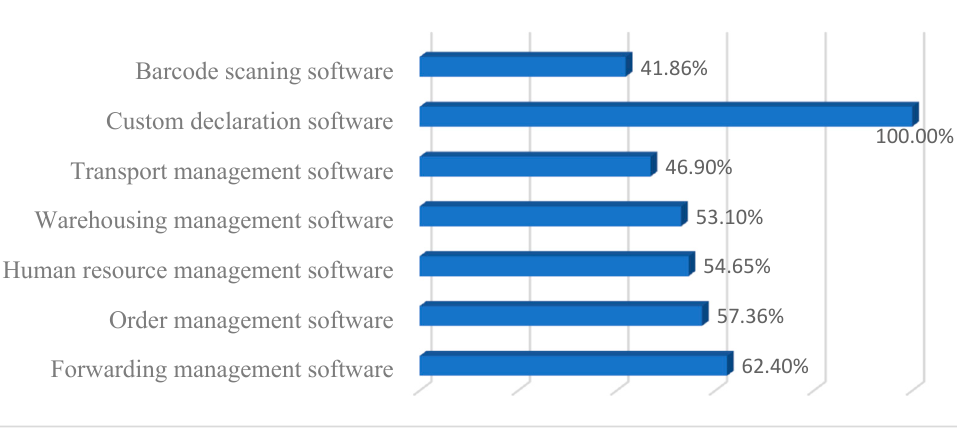
Figure 10. Software being deployed in companies.